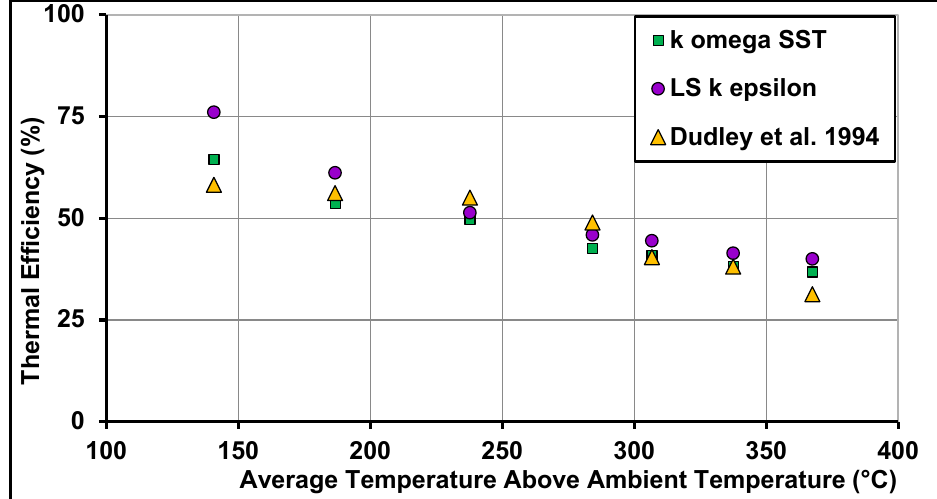
The thermal efficiency of the parabolic trough collector without the glass envelope was also validated against the experimental data of Dudley et al. [45]. It can be observed from Figure 9 that the k − ω SST model once again gave better comparisons.